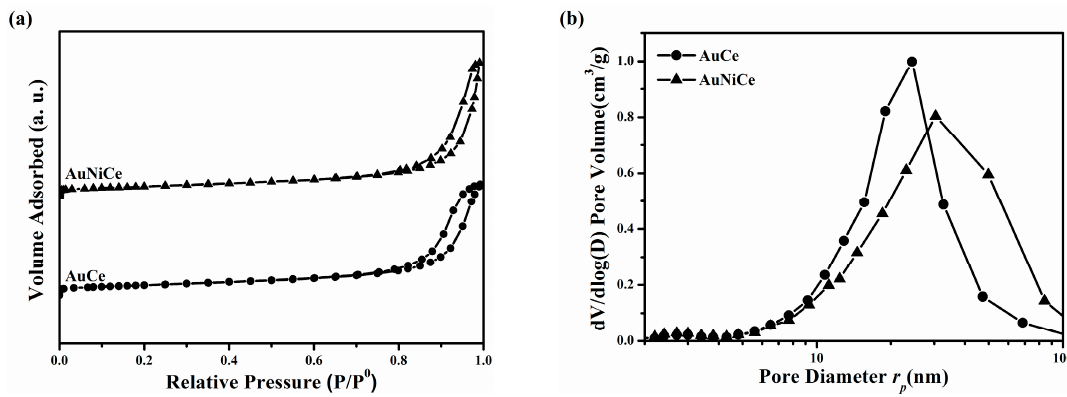
Figure 1. N 2 adsorption measurements of fresh AuNi/CeO 2 samples: ( a ) adsorption-desorption isotherm; ( b ) BJH pore size distribution.